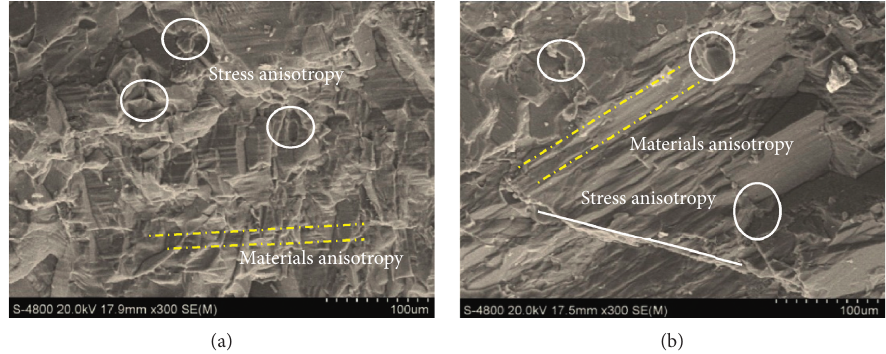
Figure 1: Images of granite debris obtained by a scanning electron microscope ( × 300). (a) Debris #1. (b) Debris